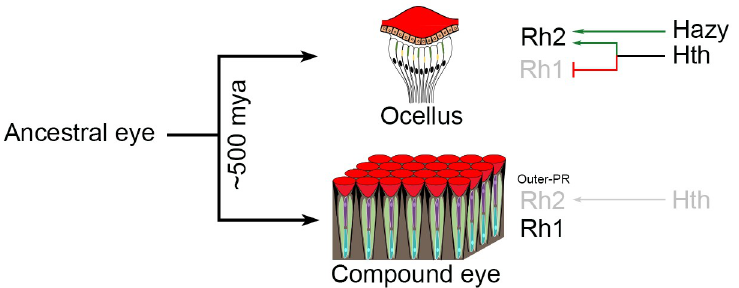
Fig 7. Model for the binary Rhodopsin switch in the ocelli. Schematic representation showing origin of ocelli and compound eye from an ancestral eye in insects around 500 million years ago. Rh2 is normally expressed in the ocelli and gets independently regulated by Hazy and Hth. Hth regulates the binary Rhodopsin switch to promote Rh2 expression in ocelli while repressing Rh1. Overexpression of hth is sufficient to promote Rh2 expression but only at the outer PRs of the